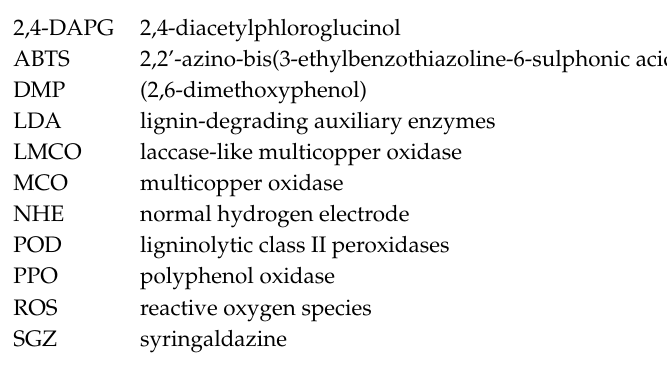
Table S1. Comparison of selected laccases from di ff erent